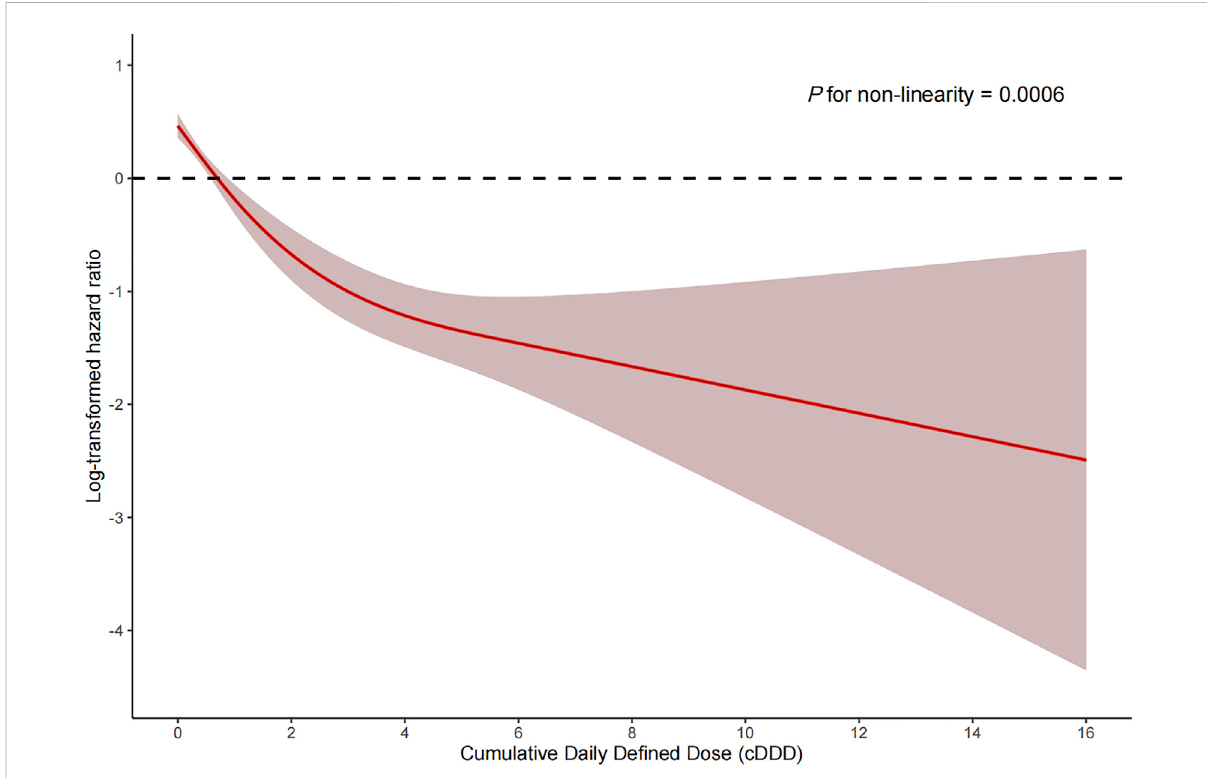
FIGURE 3 Dose-response association between the cumulative daily de fi ned dose of ACEI/ARBs and ICU mortality. p for non-linearity = 0.0006. The solid red lines represent the effect estimates and the shaded area represents 95% con fi dence intervals. Abbreviations: cDDD, cumulative daily de fi ned